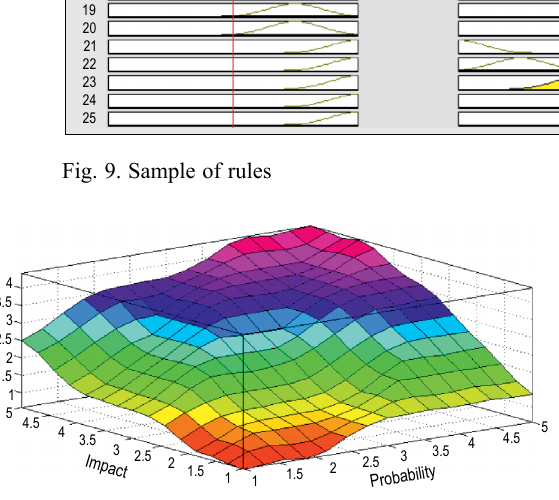
Fig. 10. Control surfaces of the